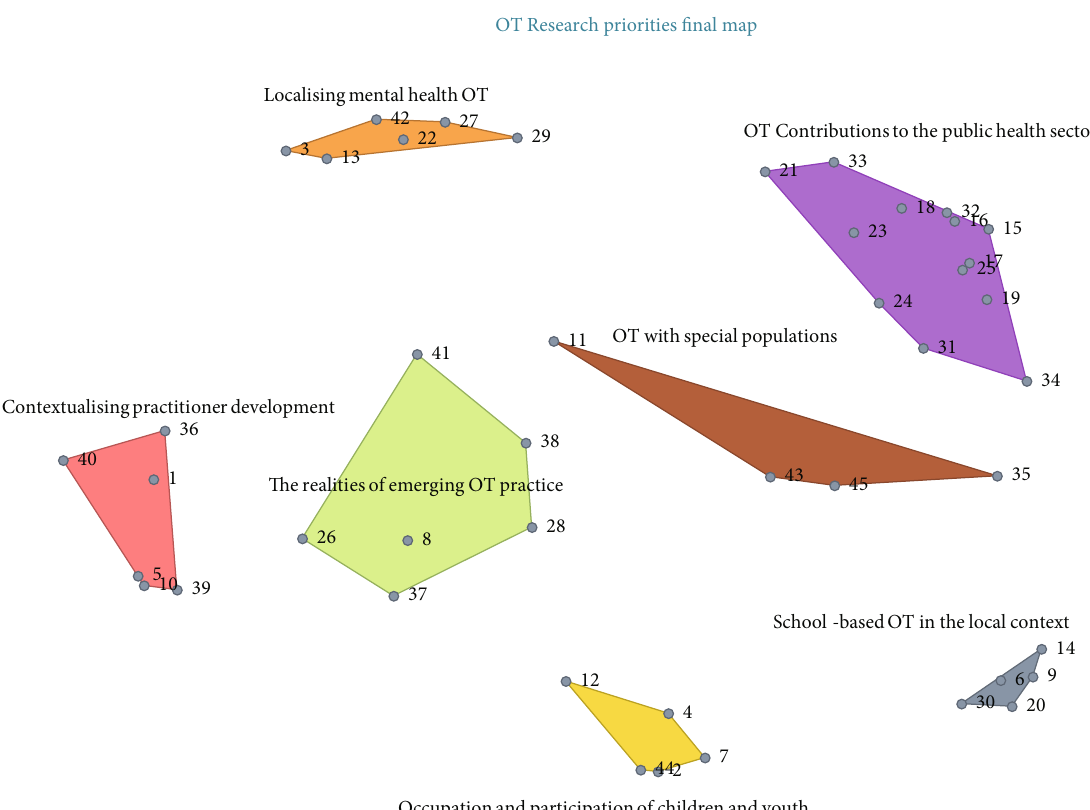
Figure 2: Point cluster map showing seven research priority themes. The map represents the distribution of each individual statement as numbered